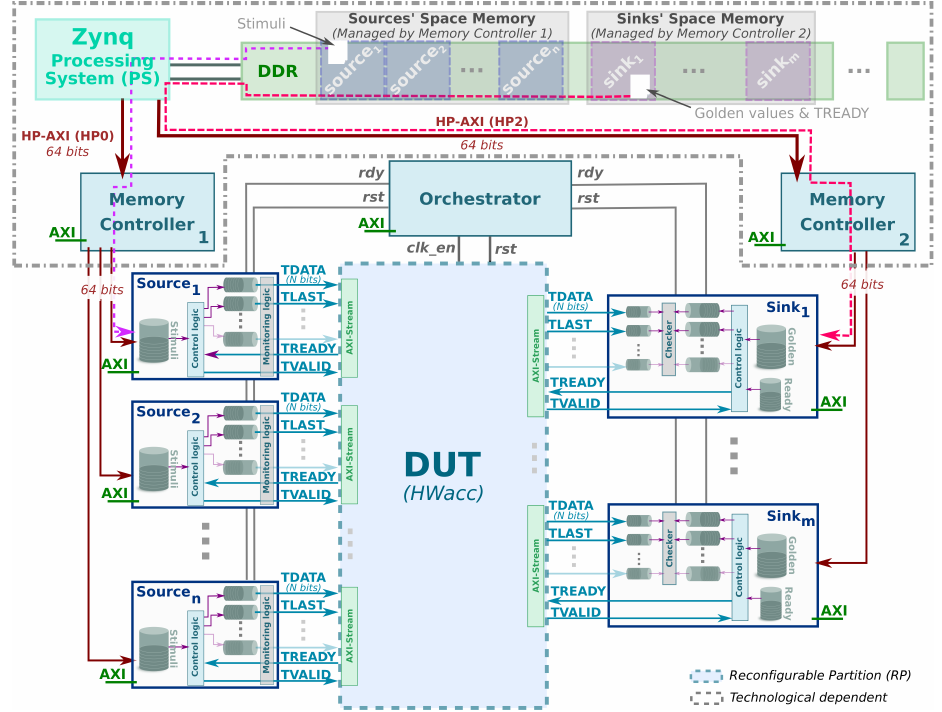
Figure 6. Overview of hardware verification platform implemented on a Zynq-7000